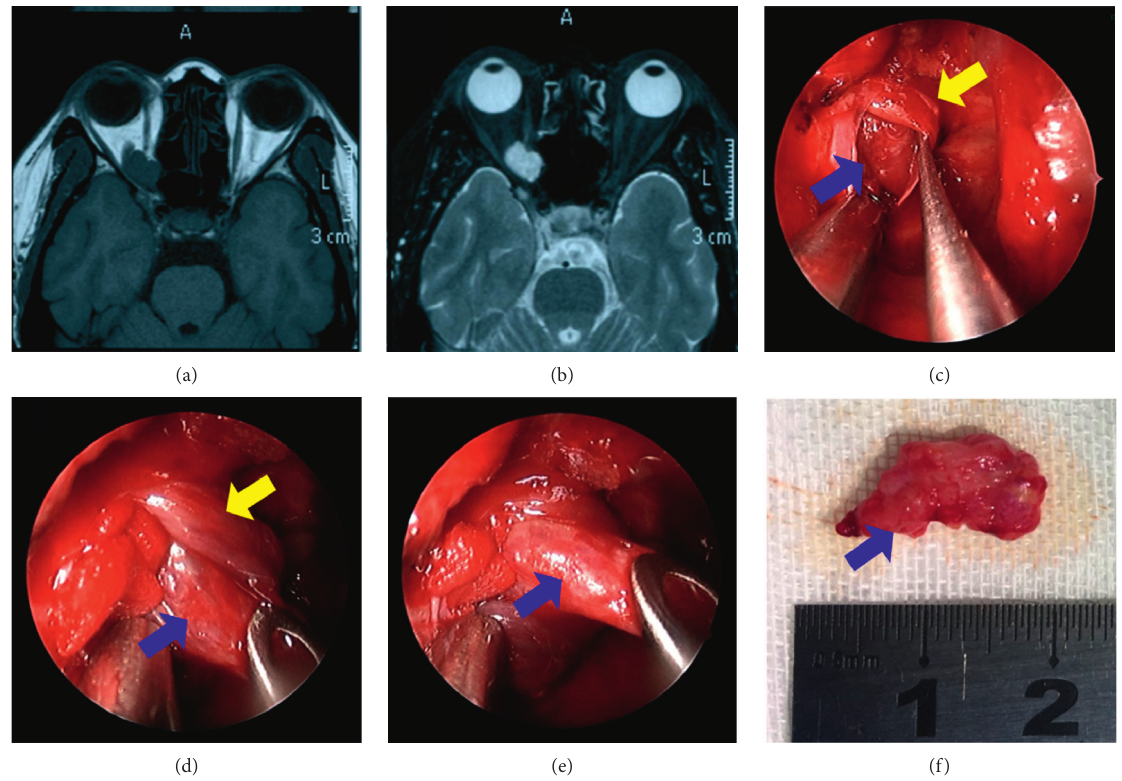
Figure 2: Magnetic resonance imaging of a patient with cavernous hemangioma of the orbital apex and surgical removal process. (a) T1- weighted images showed an isointensity mass in the right orbital apex. (b) Axial T2-weighted images showed a high-intensity mass. (c–f)The surgical removal of the cavernous hemangioma: the yellow arrow indicates the muscle and the blue arrow indicates the